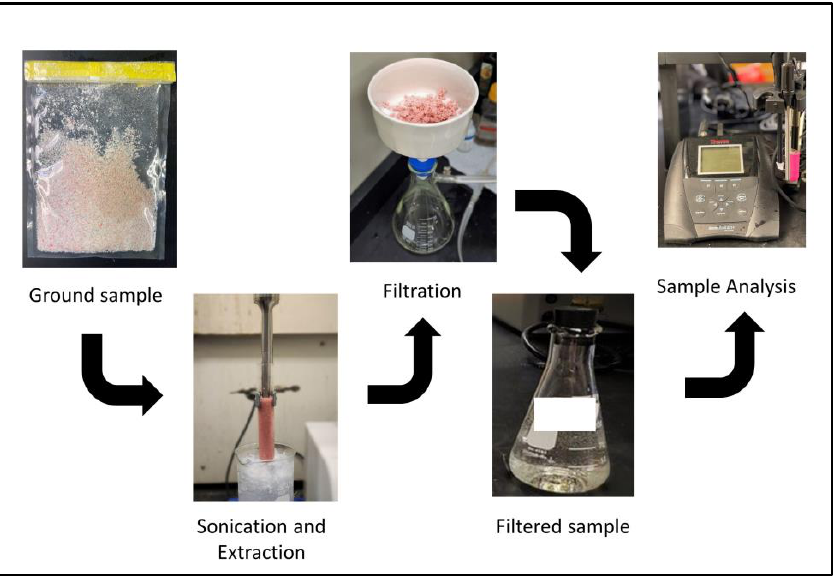
Figure 8. Total organic fluorine test procedure.